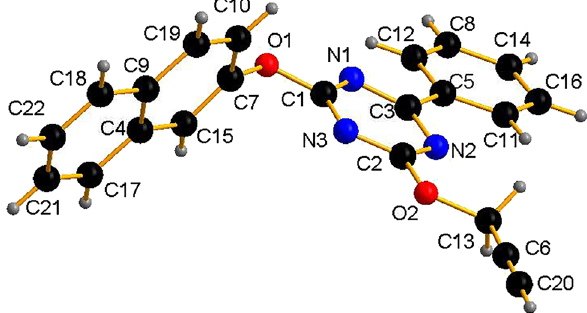
Table  : Data collection and